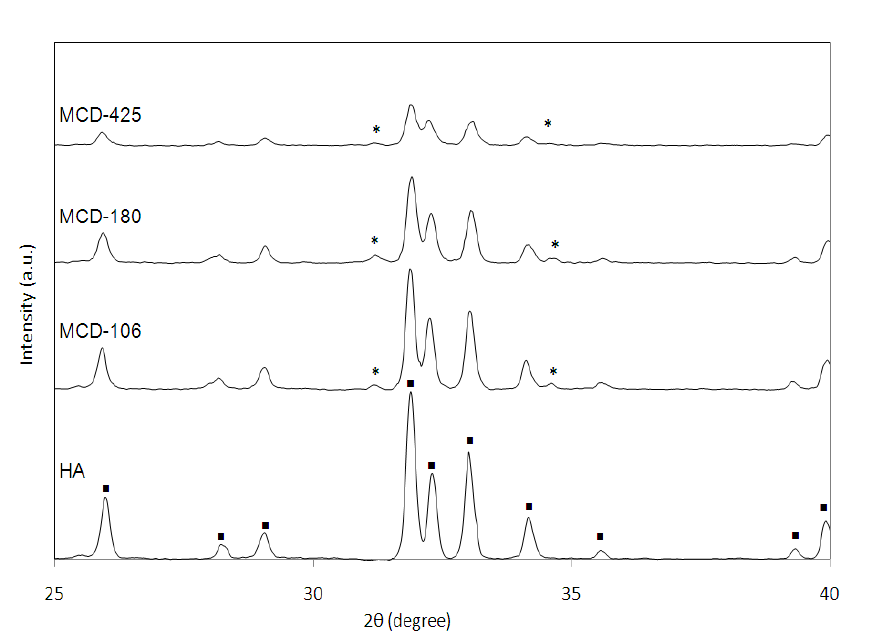
Figure 1. Powder X-ray diffraction (PXRD) spectra of the powders (■ denotes HA peaks and * represents tricalcium phosphate